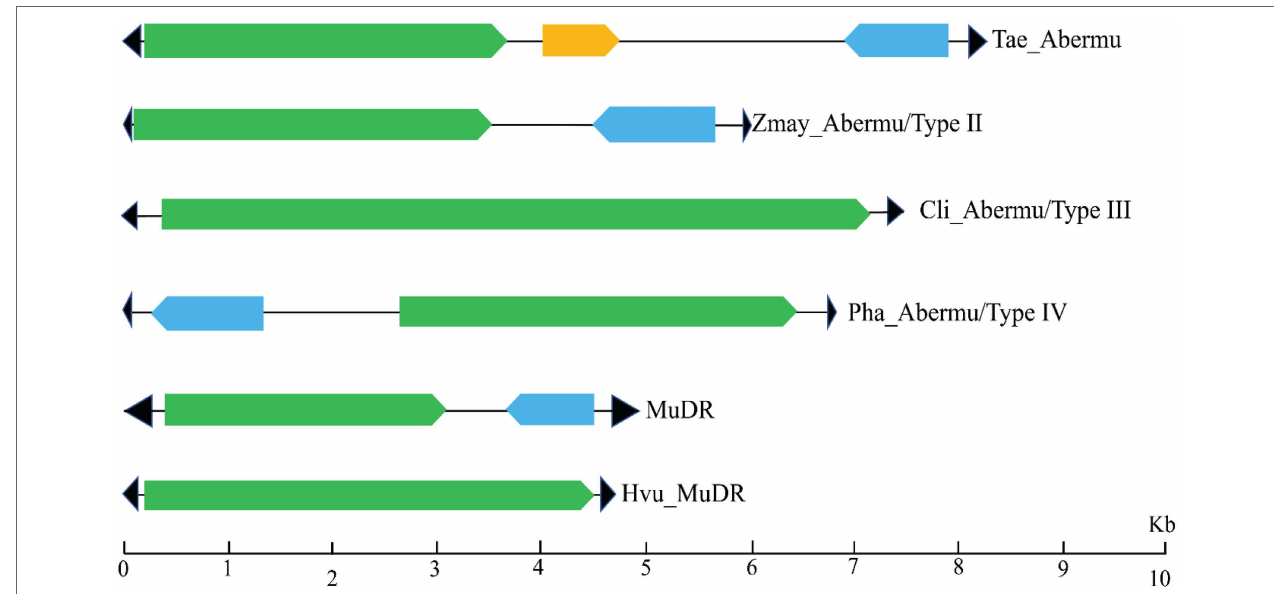
FIGURE 3 | The sequence structures of different types of Abermu transposons and MuDR elements. The black triangles represent the TIRs of transposons. The green rectangles represent the ORF (ORF1) encoding mutator transposase protein, the blue rectangles indicate that ORF (ORFR) showing opposite orientation of transcription and the orange rectangle mean the second ORF that has the same transcription orientation with